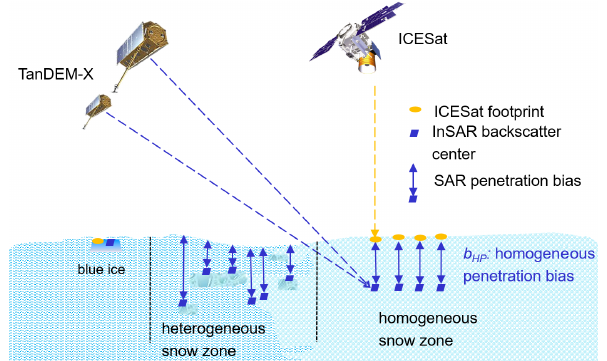
Figure 2. Schematic characterization of the snow-zone-dependent surface penetration of X-band SAR into the ice sheet. b HP denotes a homogeneous penetration bias for homogeneous snow zones.